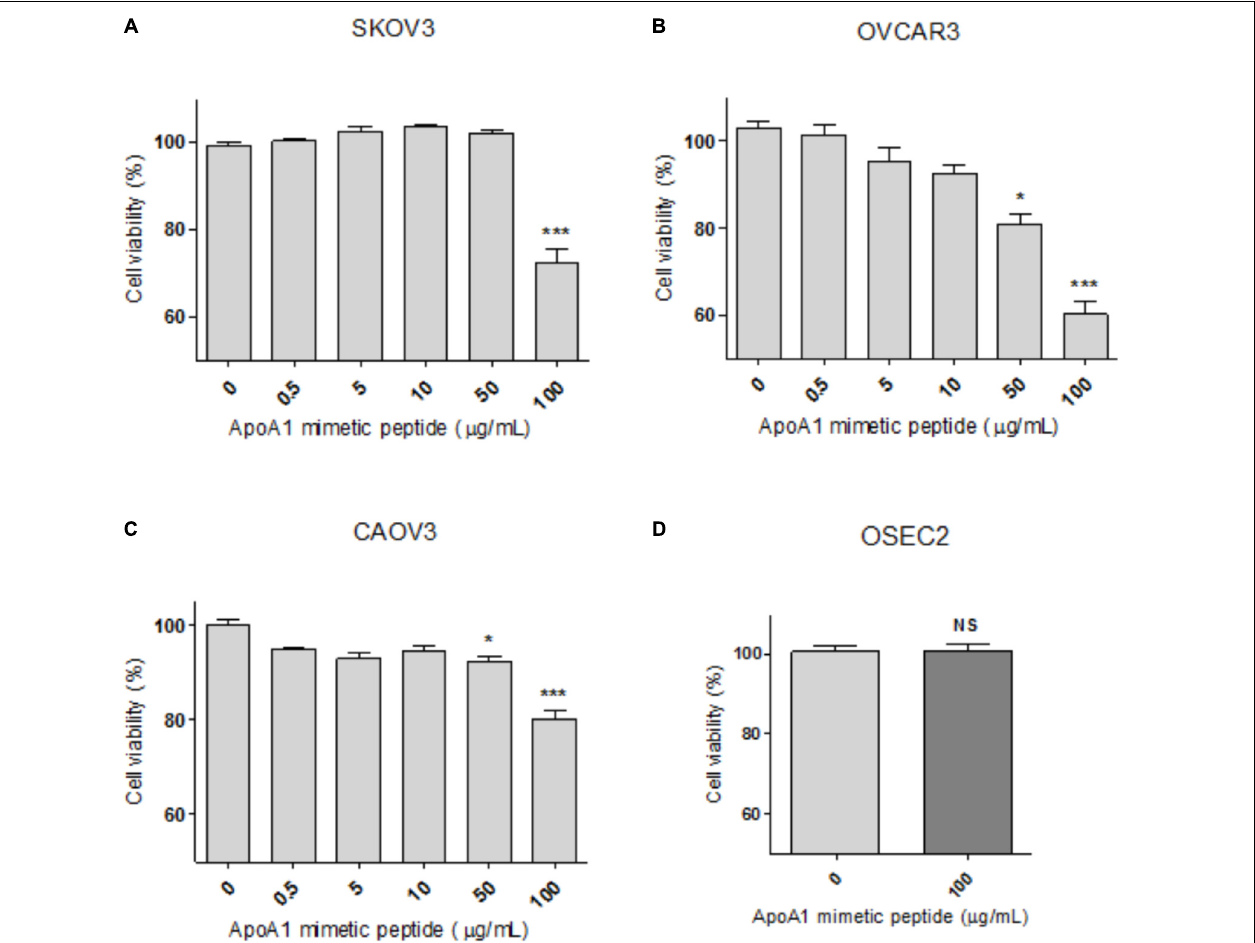
FIGURE 3 | The ApoA1 mimetic peptide decreases the viability of ovarian cancer cells without affecting non-neoplastic ovarian cells. SKOV3 (A) , OVCAR3 (B) , and CAOV3 (C) cells were incubated with the ApoA1 mimetic peptide 4F up to a concentration of 100 µ g/mL, in serum-free conditions for 48 h. Untreated cells were exposed to vehicle only. Exposure to the highest concentration of the peptide decreased the viability of all the three cell lines (Kruskal–Wallis test with Dunn’s multiple comparison post-test; p < 0.001). Immortalized non-neoplastic human ovarian surface epithelia cells (OSEC2; D ) were exposed to the highest concentration of peptide (100 µ g/mL) used in the viability assay for the ovarian cancer cell lines. At this concentration the peptide did not affect the viability of OSEC2 cells. Differences were considered significant if p < 0.05. ∗ p < 0.05, ∗∗∗ p < 0.001.